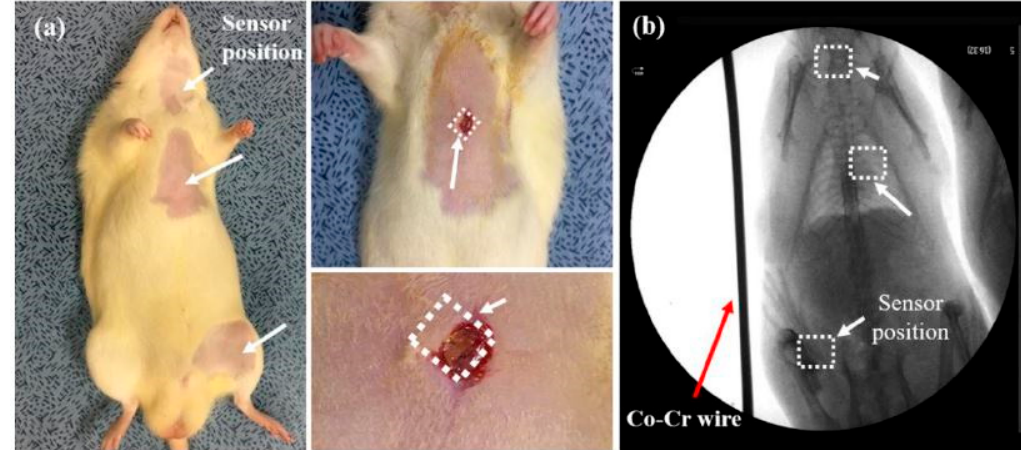
Figure 1. The insertion of wireless pressure sensors into the animal was done ( a ) at three different places ( b ) to perform the biocompatibility test and determine the blood pressure [69]. The image has been reproduced with permission from [69].